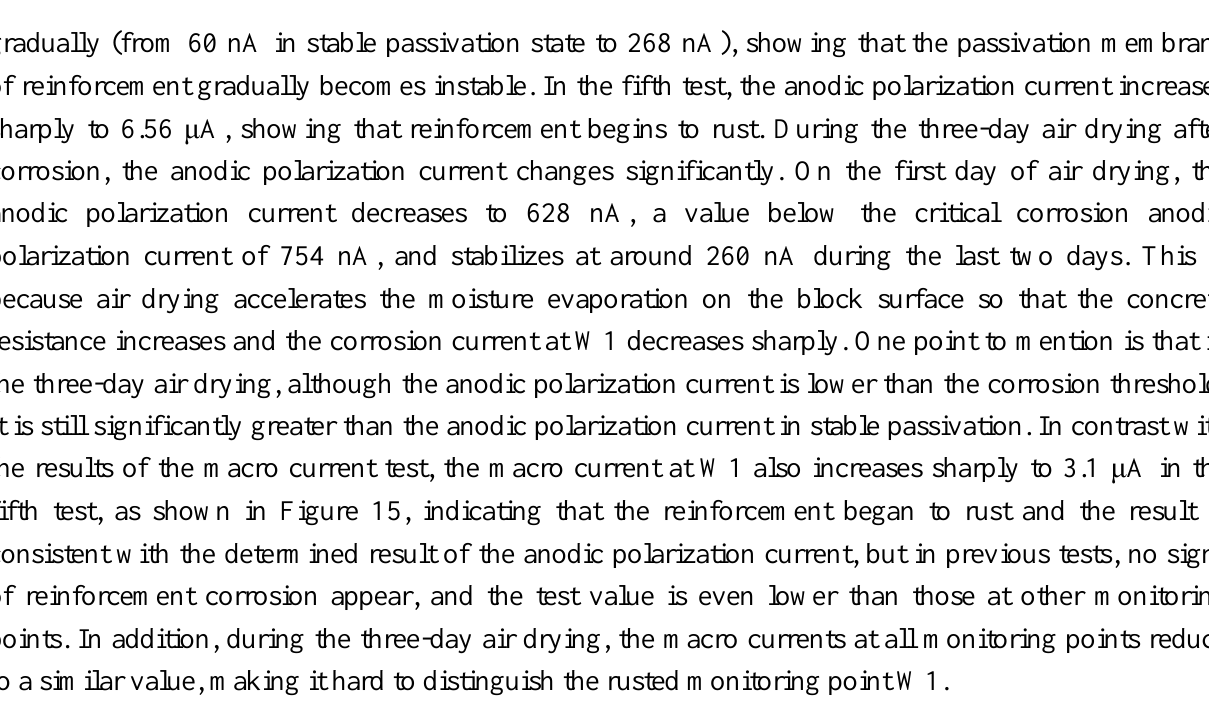
Figure 14. Variation of anodic polarization current for each monitoring point.